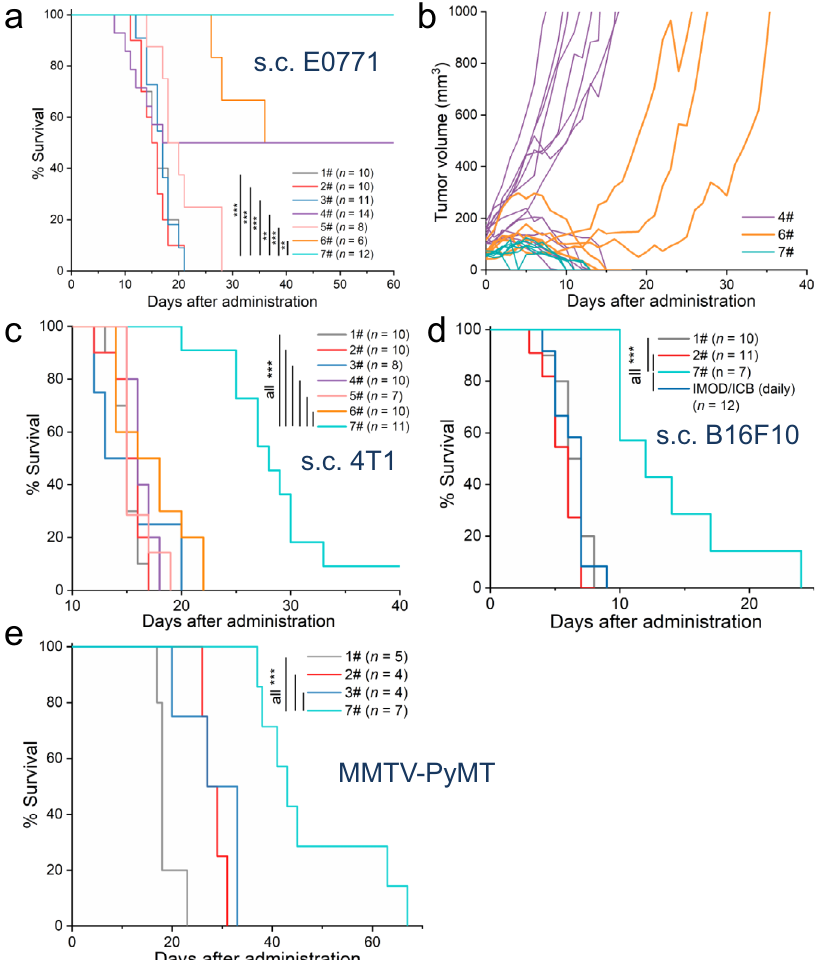
Fig. 4 Effects of IMOD combining PDT and daily administration of ICB antibodies on tumor growth and survival in mice. a, b Treatments performed in subcutaneous (s.c.) E0771 tumors in C57BL/6 mice ( n = 6 – 14). Treatment regimens in ( a ), ( c ), ( d ), and ( e ): 1#, untreated; 2#, IMOD/PDT (q3d × 2); 3#, ICB (i.p. q3d × 4); 4#, ICB (i.t. q3d × 4); 5#, ICB (i.p. daily); 6#, IMOD/PDT (q3d × 2) + ICB (i.p. q3d × 4); 7#, IMOD/PDT × 2/ICB (daily).